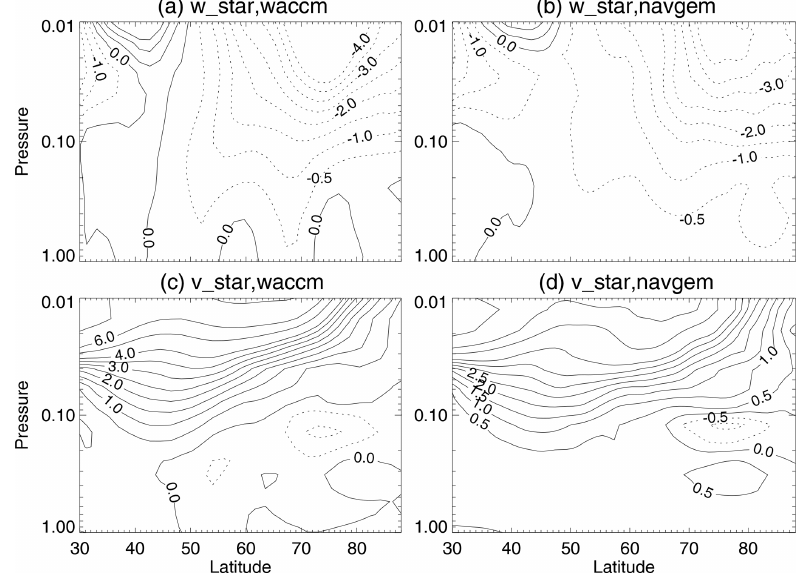
Figure 8. Comparison of monthly mean (February) w ∗ (a, b) and v ∗ (c, d) for WACCMX (a, c) and NAVGEM-HA (b, d) . For w ∗ , the units are cm/s with a contour interval of 0.5cm/s, and for v ∗ , the units are m/s and the contour interval is 0.5m/s. Negative values are dotted